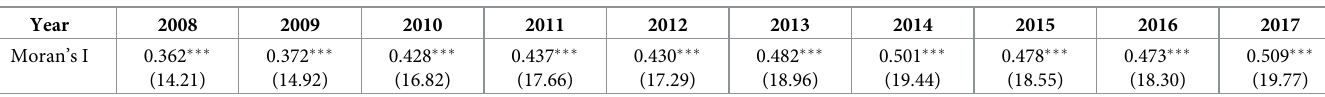
Table 4. Moran’s I